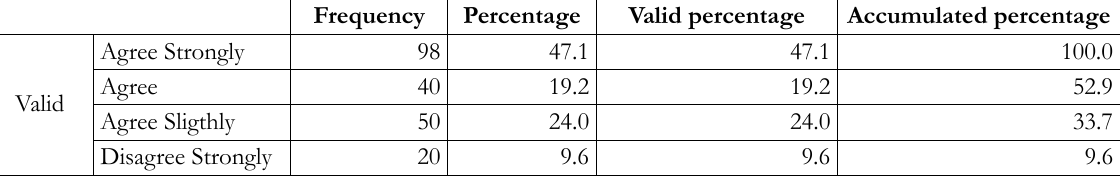
Table 4. If deemed necessary the change of teaching-learning methodology applied currently